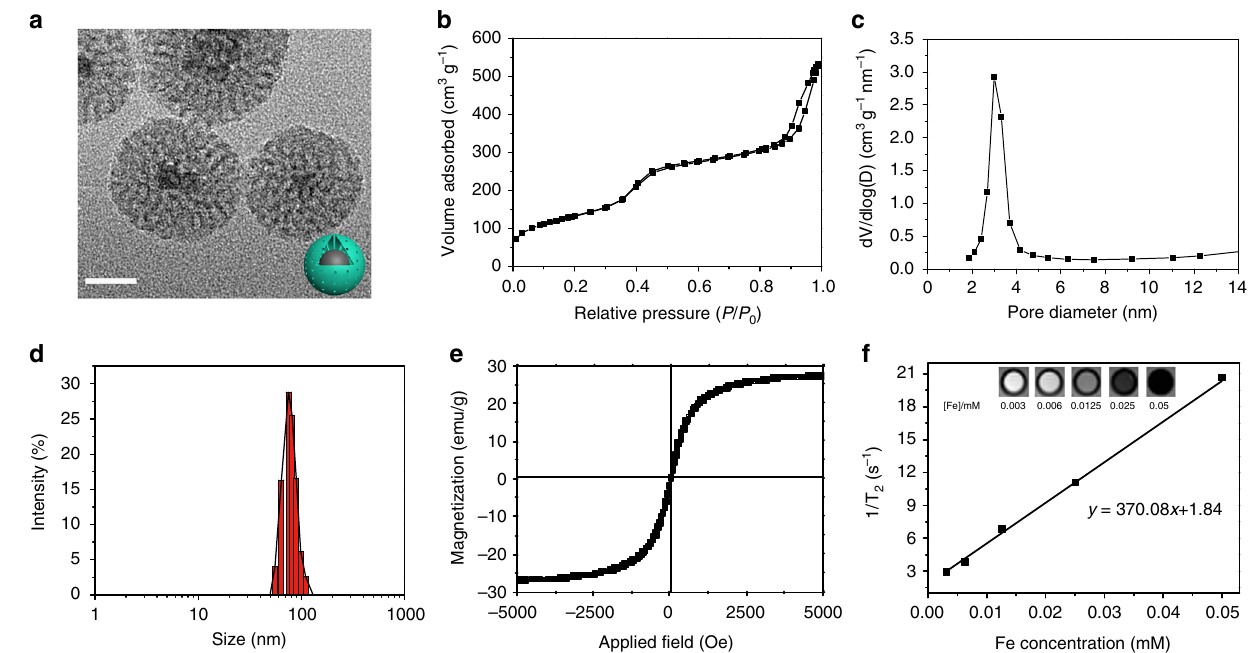
Fig. 2 Structural and compositional characterizations of MMSNs. a TEM image of MMSNs. Scale bar: 20 nm. b N 2 adsorption − desorption isotherm and c corresponding pore-size distribution of MMSNs. d The hydrodynamic particle-size distribution of MMSNs in aqueous solution by DLS measurement. e Field-dependent magnetization curve of MMSNs measured at room temperature. f Plots of T 2 − 1 versus Fe concentration and concentration-dependent T 2 -weighted MR imaging for MMSNs solution. Transverse relaxivity ( r 2 ) was derived from linear fi tting of the